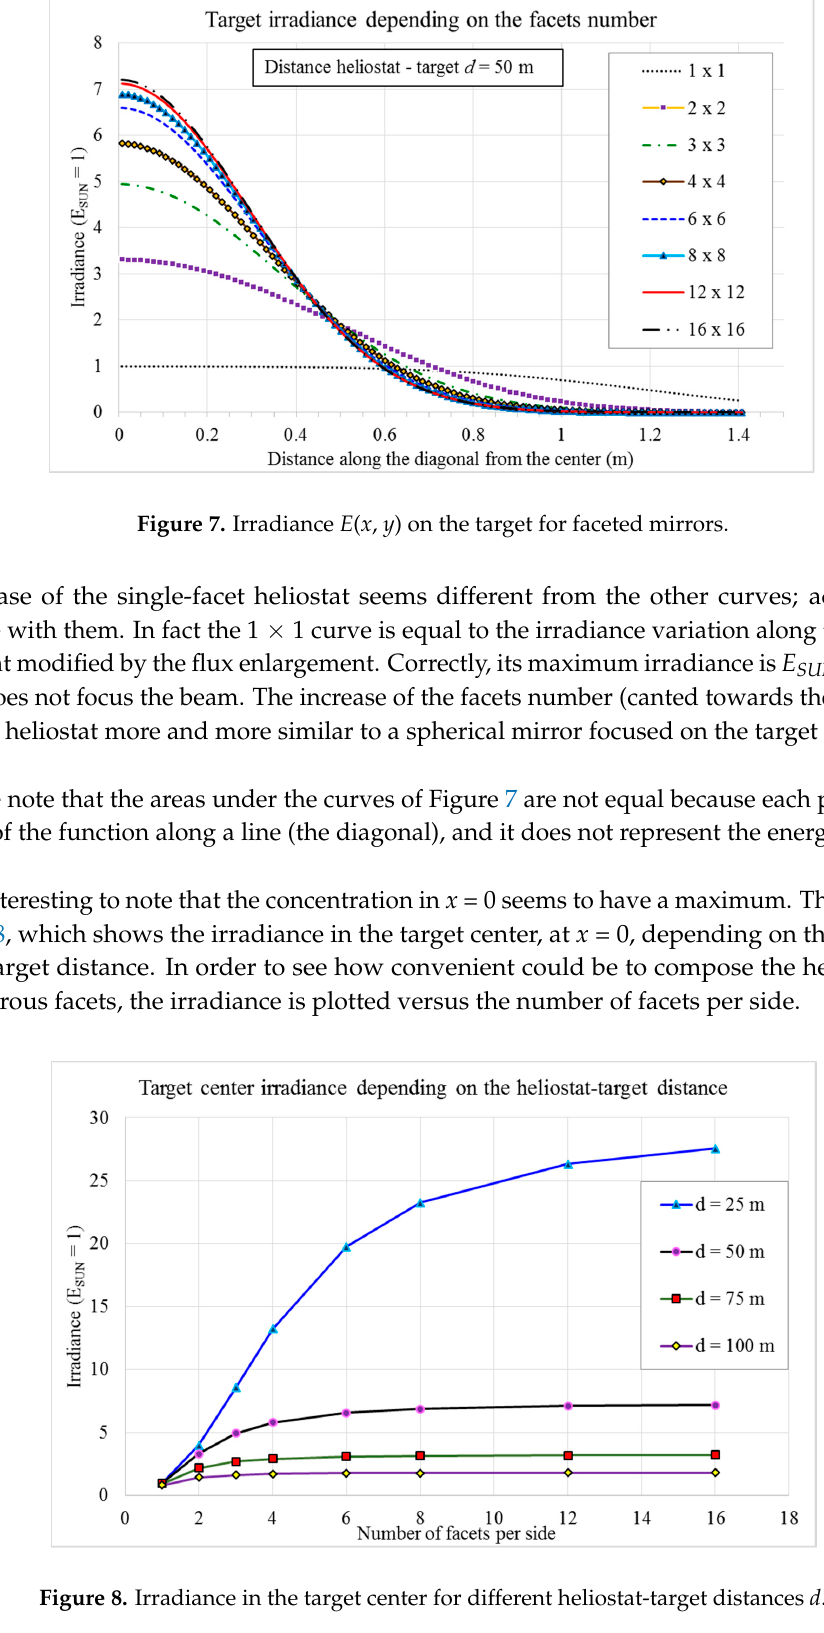
Figure 8. Irradiance in the target center for different heliostat-target distances d .